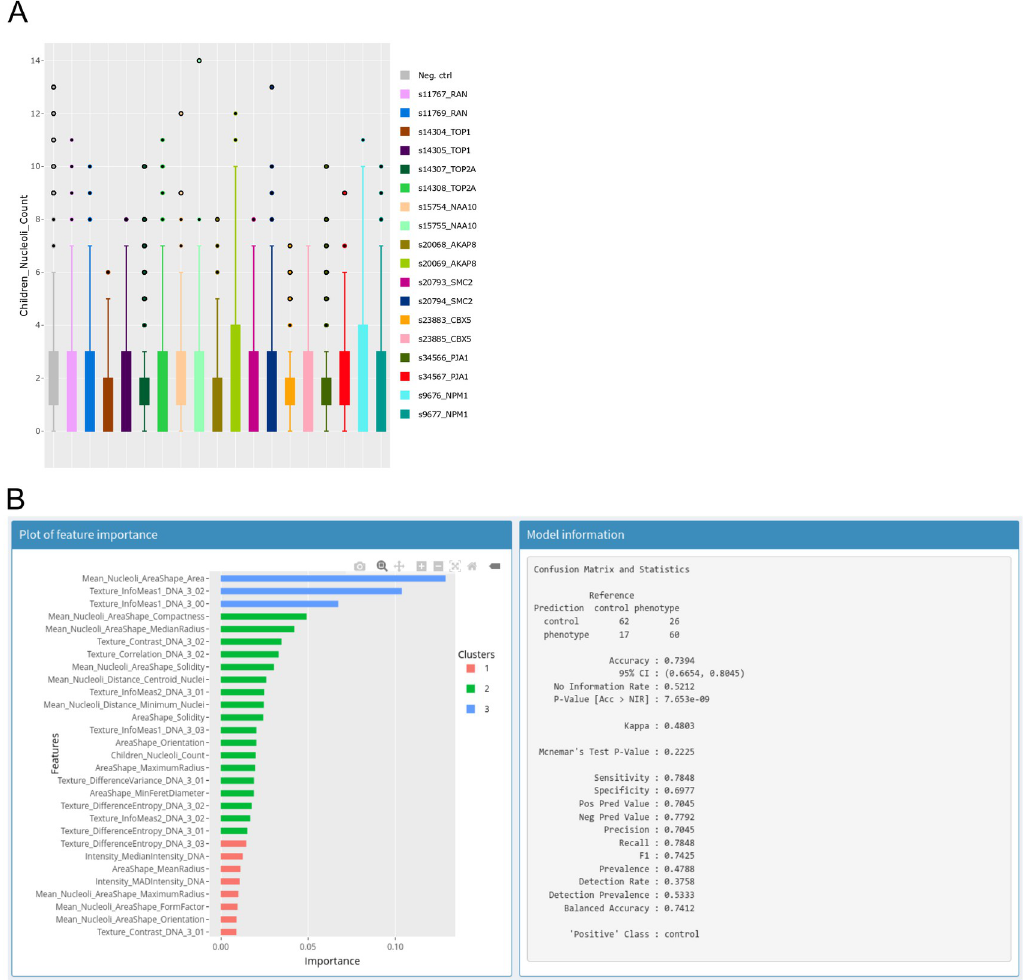
Fig 3. A—Box plot of nucleolar number per siRNA as produced by the IDE. Each colour corresponds to data from one siRNA. B —Output of the XGBoost classifier. Left panel: Plot of relative feature importance, colours are used to indicate clusters of features with similar importance. Right panel: Information ato assess performance of the trained